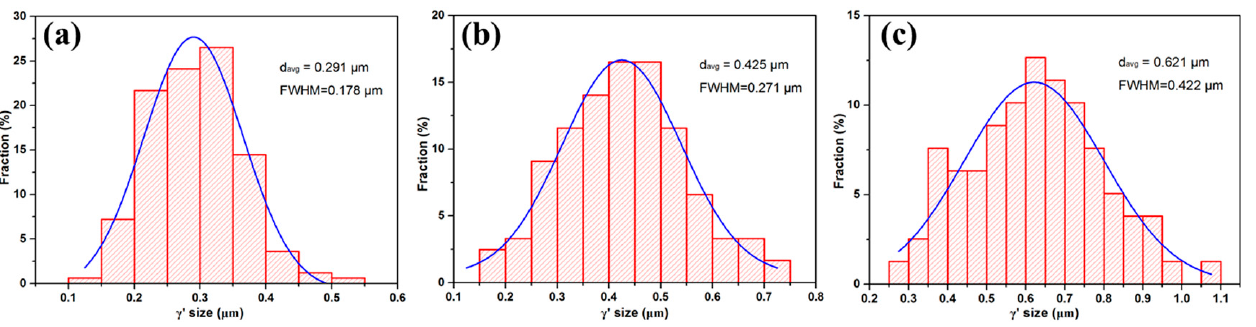
Figure 4. The size distribution of secondary γ′ precipitates after heat treatment under different cooling rates: ( a ) WQ, ( b ) AC and ( c ) HT. Table 3. Size and area fraction of γ′ phase after heat treatment under different cooling rates.